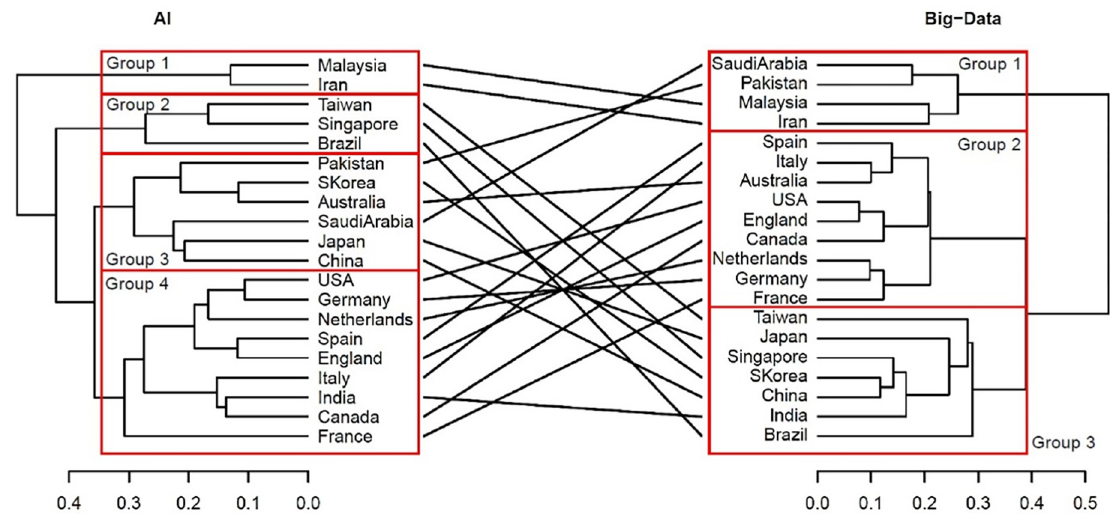
Fig 19. Country similarity tanglegram: Links between author research areas in the top 20 countries for artificial intelligence and big data. Note . Distance: hclust ( � , “ward.D2”).